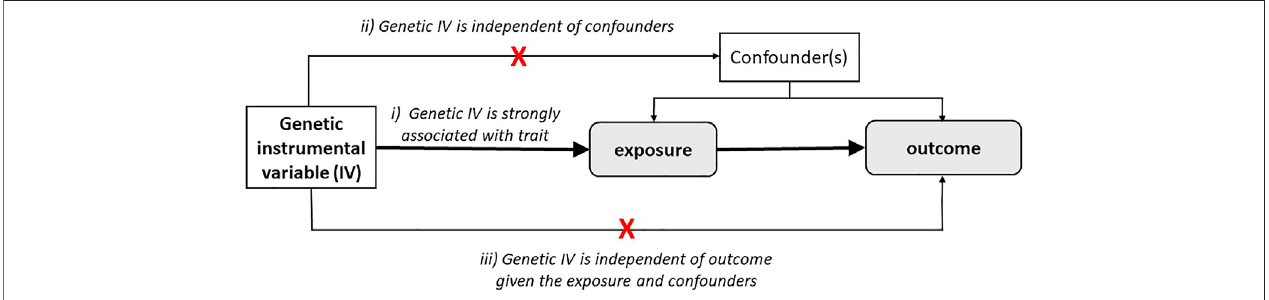
FIGURE 2 | Schematic representation of Mendelian Randomization strategy. Mendelian randomization estimates the causal relationship of the trait (exposure) on othertraits (outcome) through geneticvariants asinstrumentvariables (IVs). MR studiesrely onthree mainassumptions:i) IVs arestrongly associatedwiththeexposure, ii) IVs are not associated with confounders, and iii) IVs affect the outcome solely through the